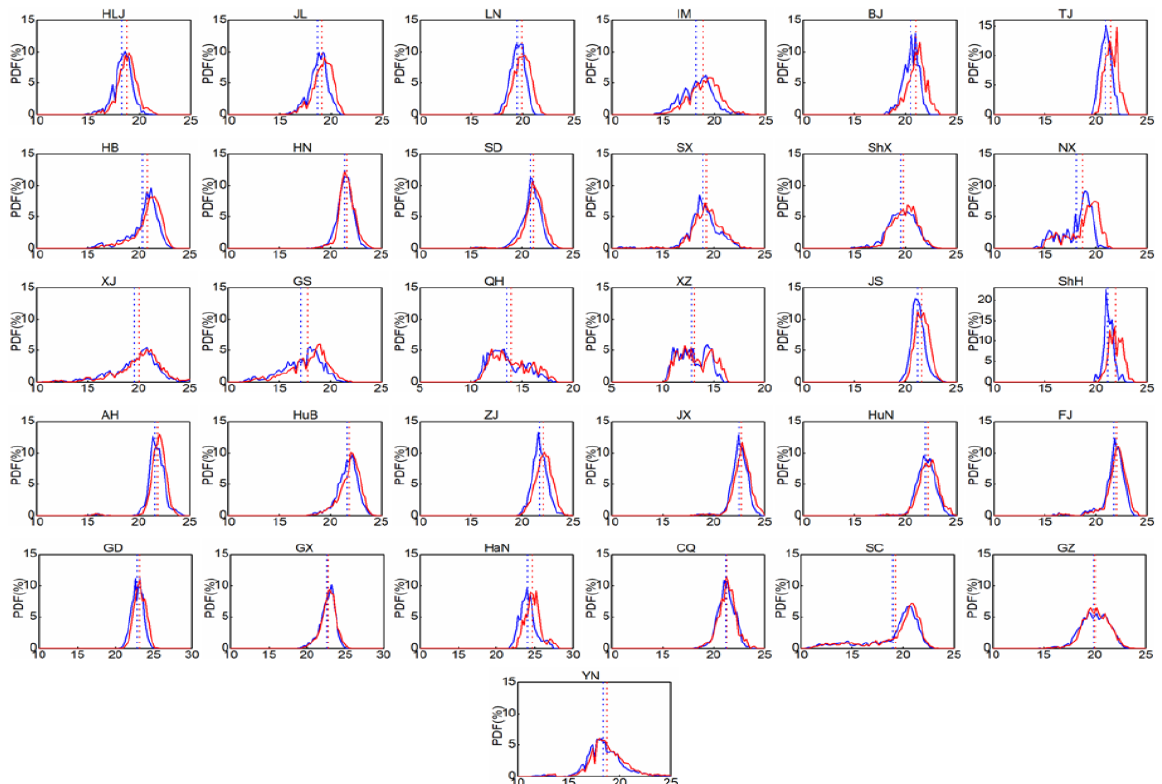
Figure 3. Differences in mean air temperature, precipitation, and insolation during the potential agricultural growing season in 1991–2020 relative to 1961–1990.